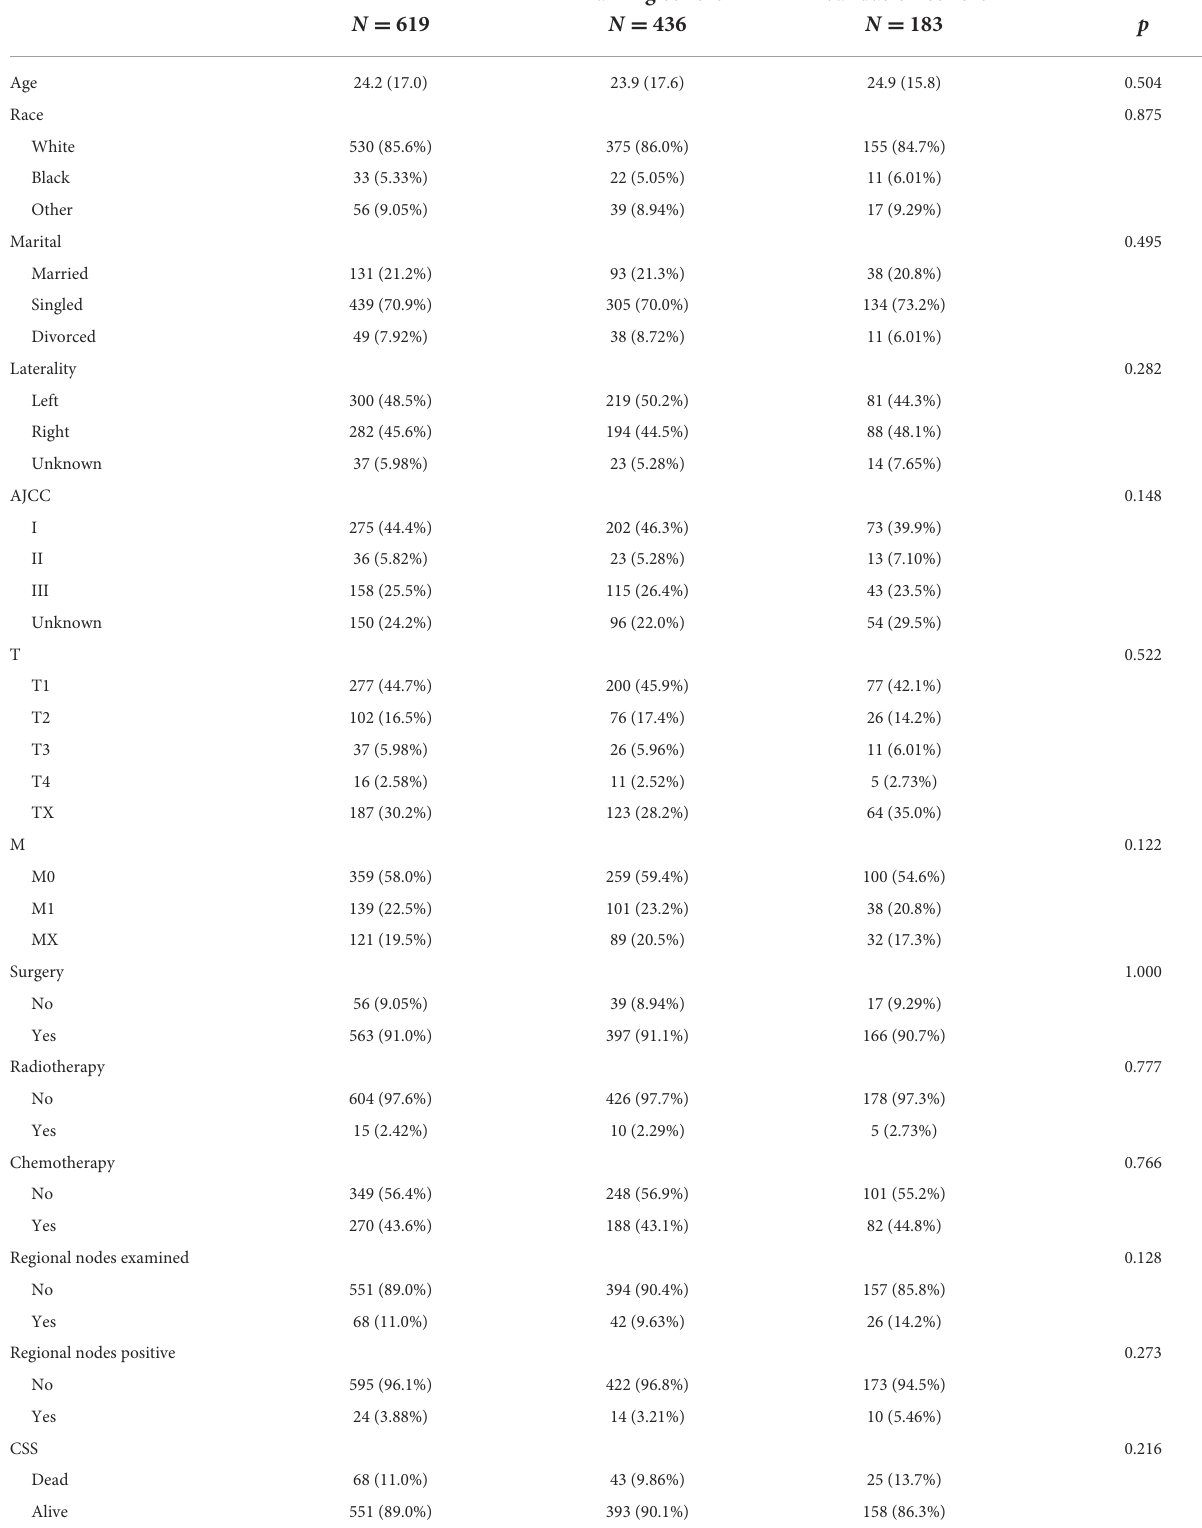
TABLE 1 Clinical characteristics of patients with